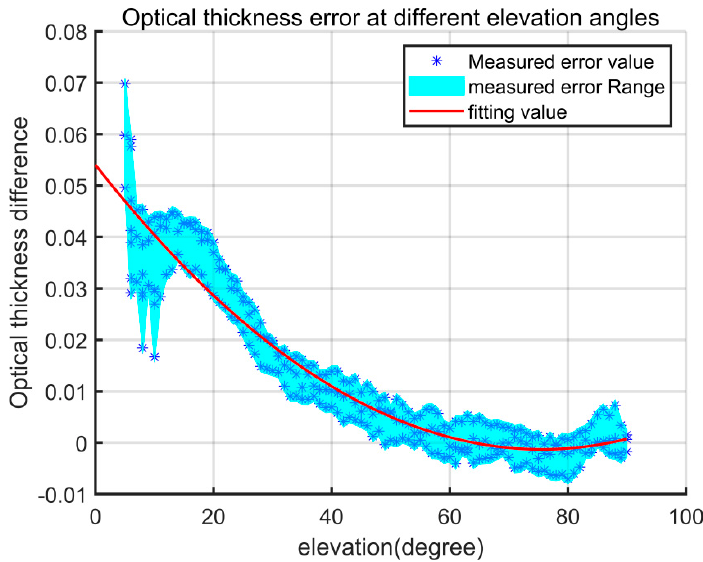
Figure 11. The optical thickness error at different elevation angles.